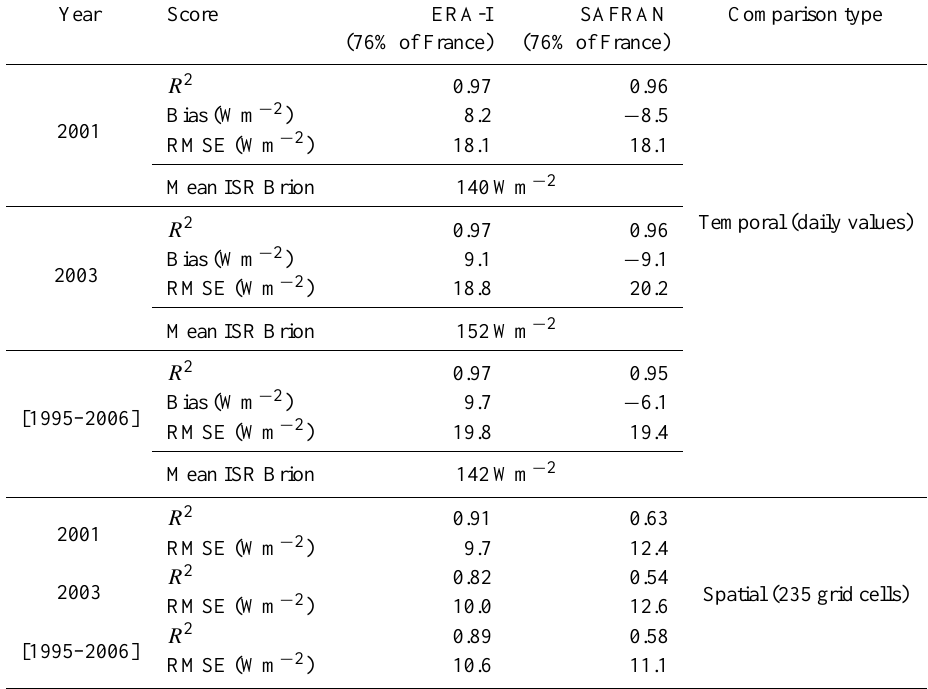
Table 4. Average ISR over the France domain where Brion dara are available, in 2001, 2003, and over the 1995–2006 period: mean bias (ERA-I minus other data sets), RMSE and squared correlation coefficient for ERA-I and SAFRAN with respect to Brion data (based on daily values), and RMSE and squared correlation coefficient for the spatial repartition of the average annual ISR (for 308 grid cells). Year Score ERA-I SAFRAN Comparison type (76% of France) (76% of France) 0.97